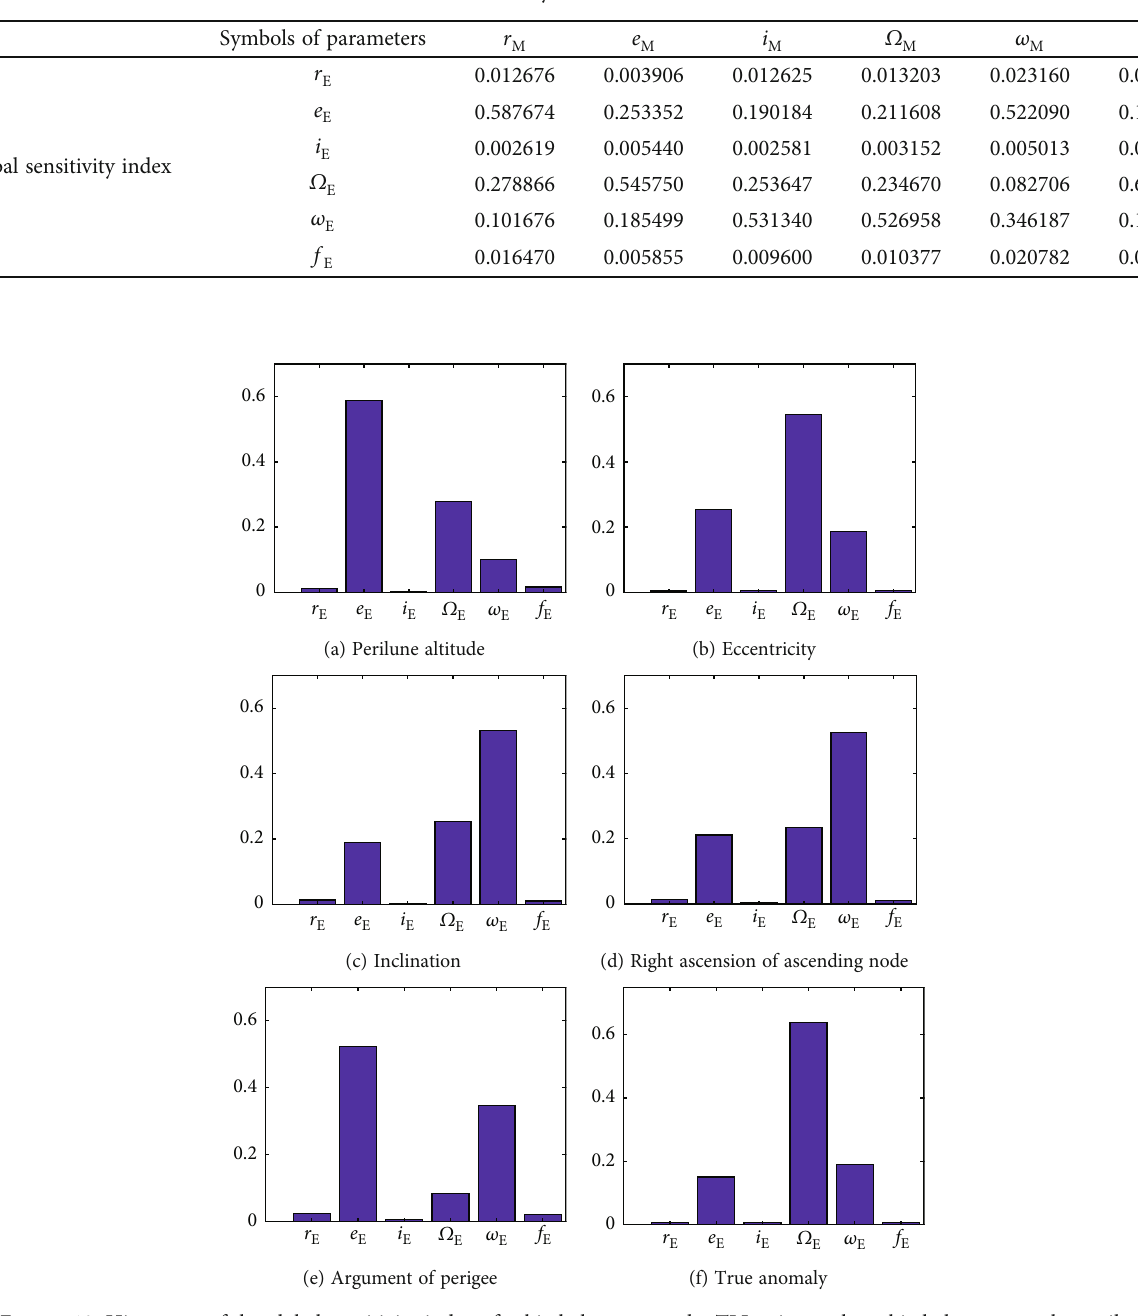
Figure 12: Histogram of the global sensitivity index of orbital elements at the TLI point to the orbital elements at the